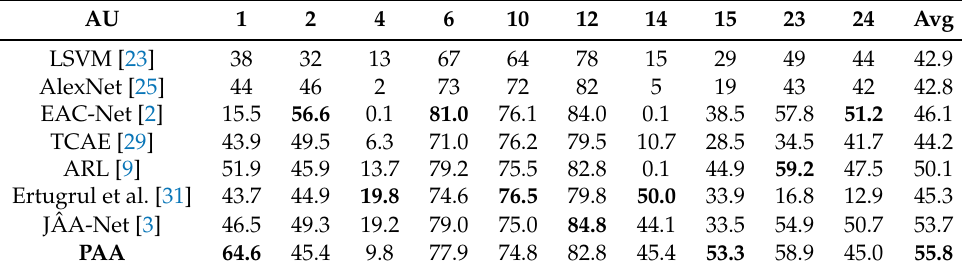
Table 3. F1-frame results of Sayette Group Formation Task (GFT) [20]. The results of LSVM [23] and AlexNet [25] are from [20], those of EAC-Net [2] and ARL [9] are from [3], and those of other previous methods are reported in their original papers. The best results of each AU, as well as the average across methods, are shown in bold. Our PAA method outperforms all the other